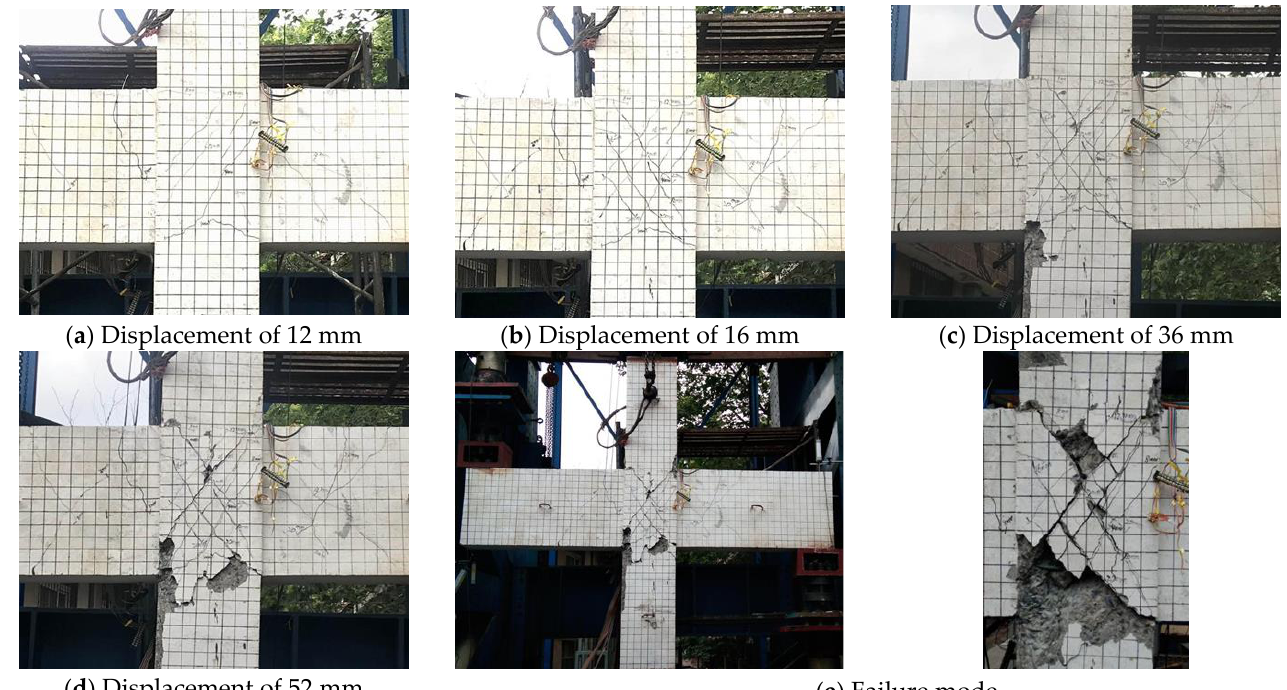
Figure 15. Crack development and failure of specimen ZJ-4.